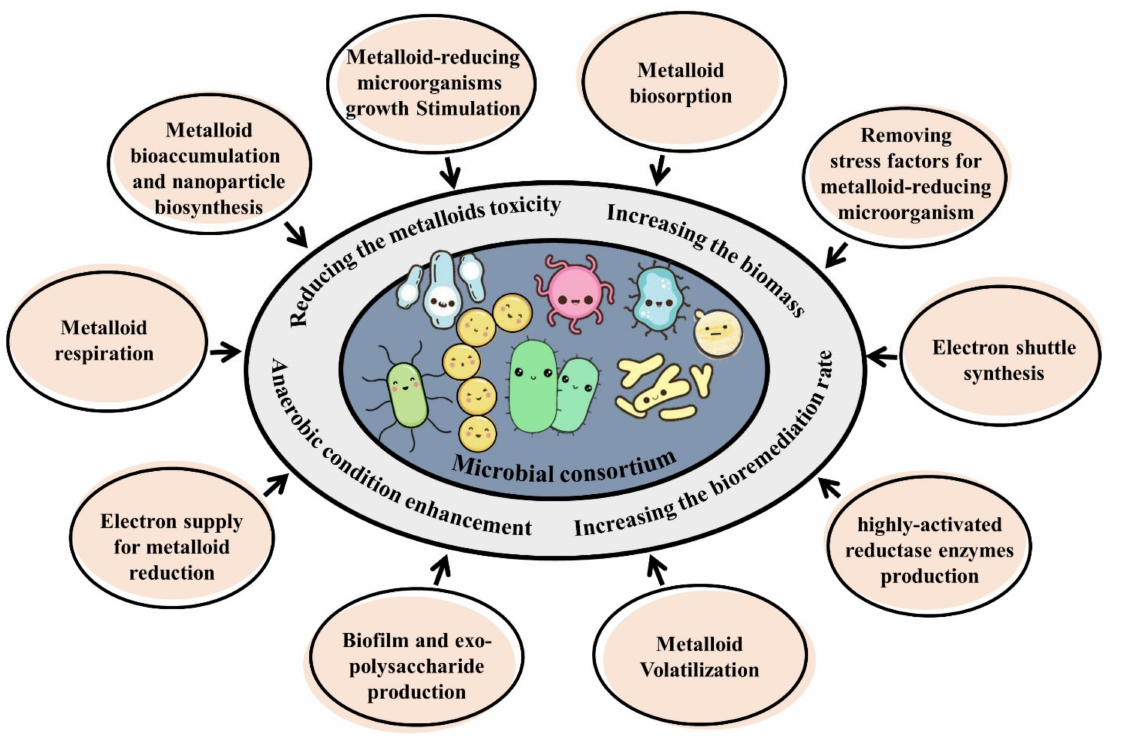
Figure 4. Some mechanisms proposed to attenuate the toxicity of metalloids in the